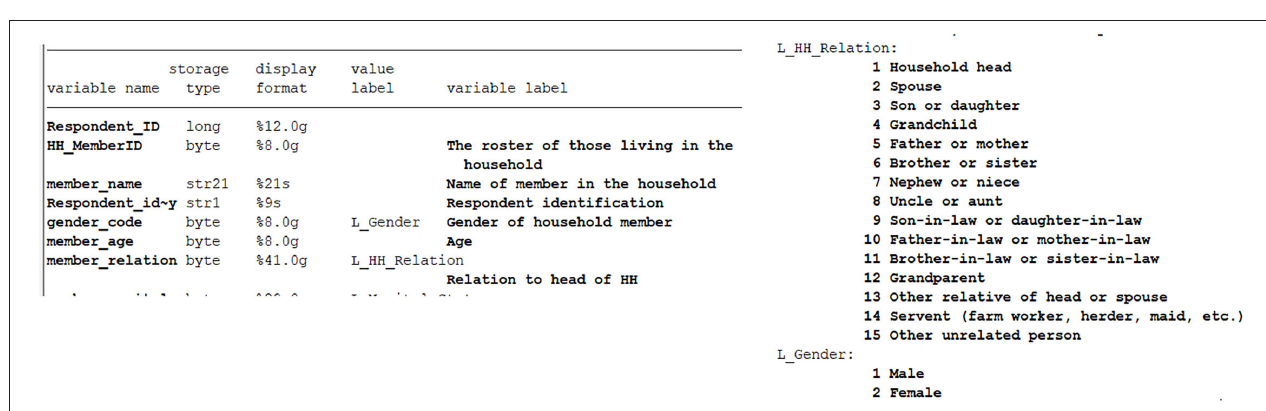
FIGURE 4 | Extractable metadata from